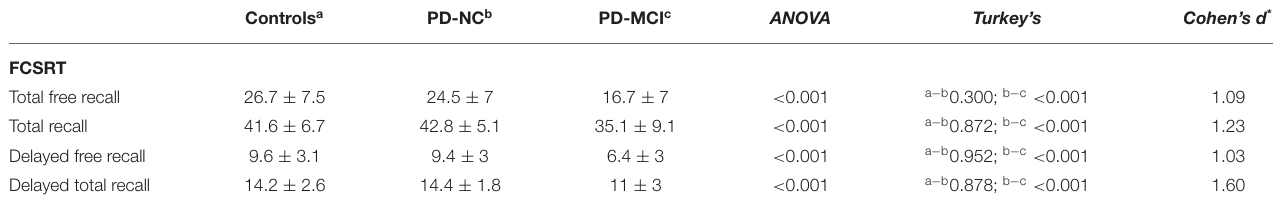
TABLE 3 | Comparative FCSRT performance between PD-MCI, PD-NC and HC.